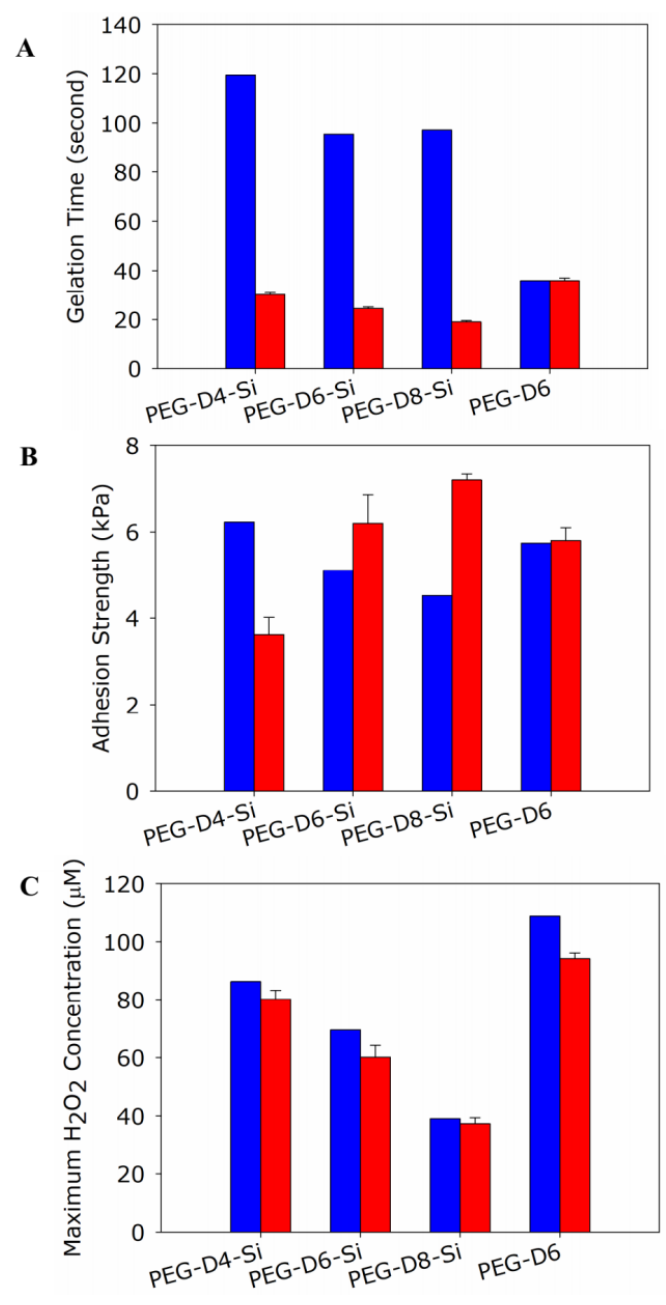
Figure 4. Predicted ( (cid:4) ) and experimental ( (cid:4) ) results for the gelation time ( A ), adhesion strength ( B ), and H 2 O 2 concentration ( C ) of the four chosen adhesive formulations. Number of repeats is